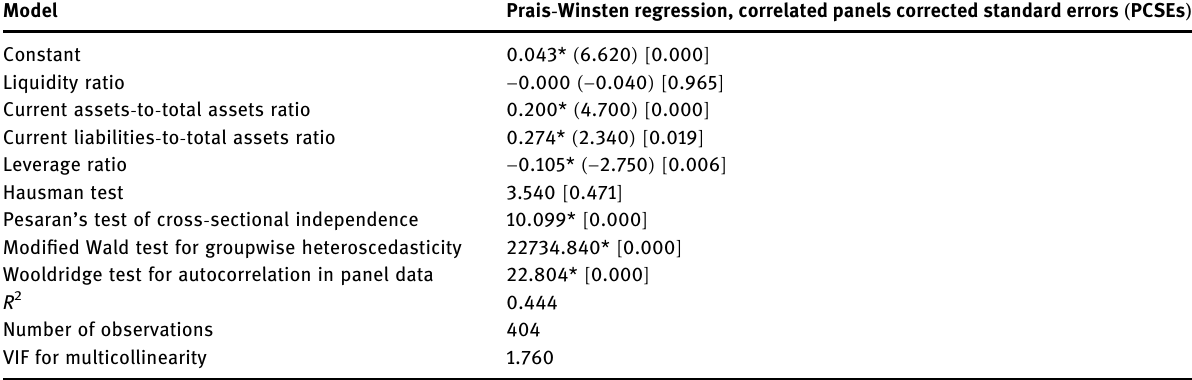
Table 8: Regression results for the fi nancial performance as dependent variables with panel data across the 28 former European Union countries and over the period 2004 –